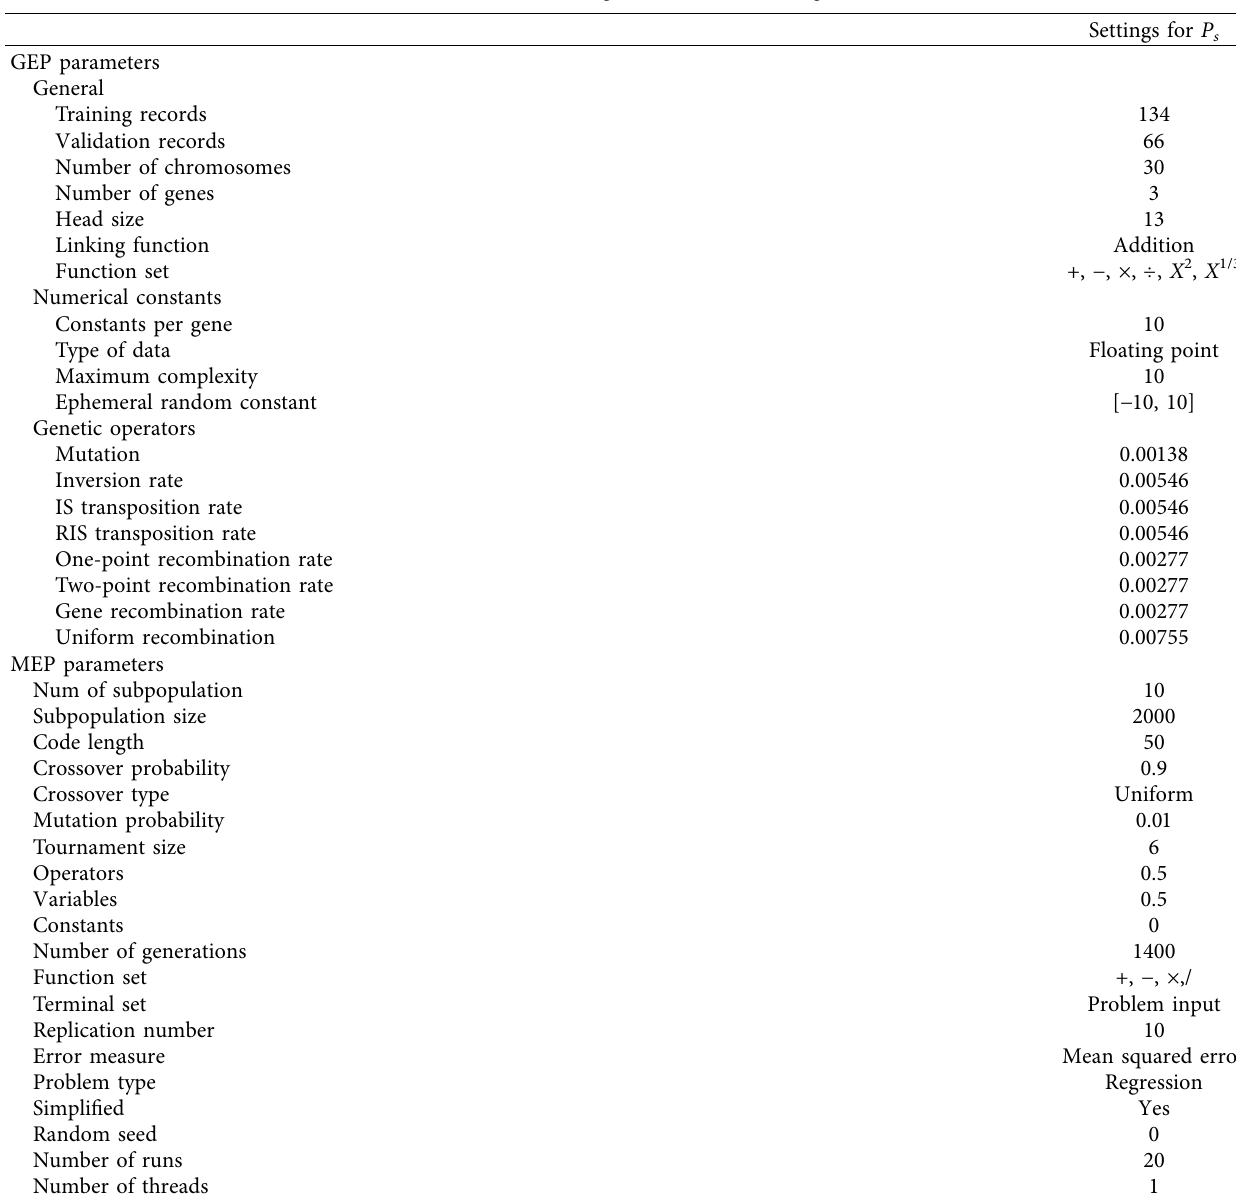
Table 4: Parameters setting for GEP and MEP